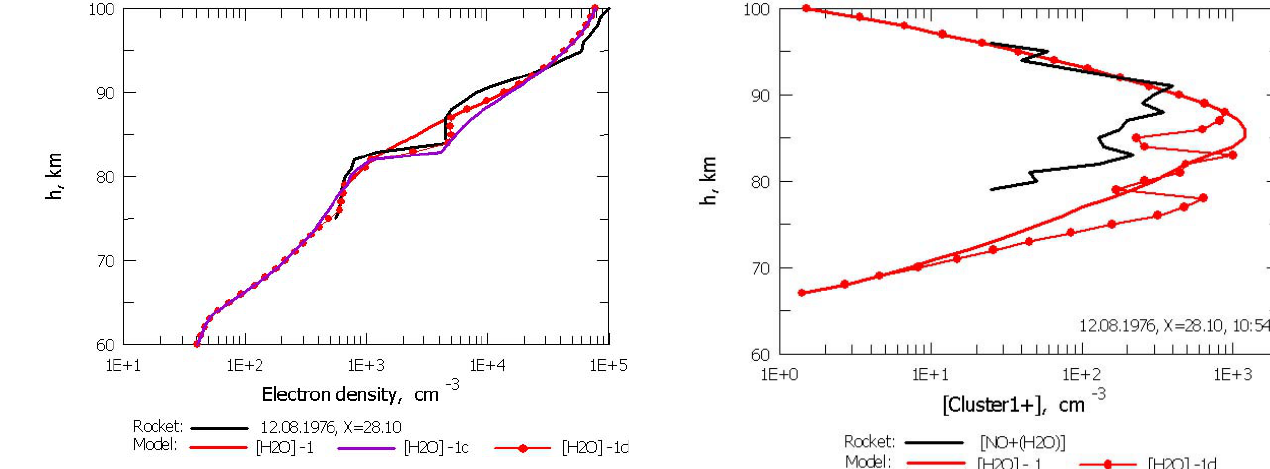
Fig. 10a. Number density profiles of the Cl + positive cluster family 1 calculated for 12 August 1976 at 10:54LT, with a solar zenith angle of 28.10 ◦ using the H 2 O-1 (red line without symbols) and H 2 O-1d (red line with symbols) profiles. The black line represents the num- ber density profile for the NO + .H 2 O hydrated cluster ion measured by Kopp et al.